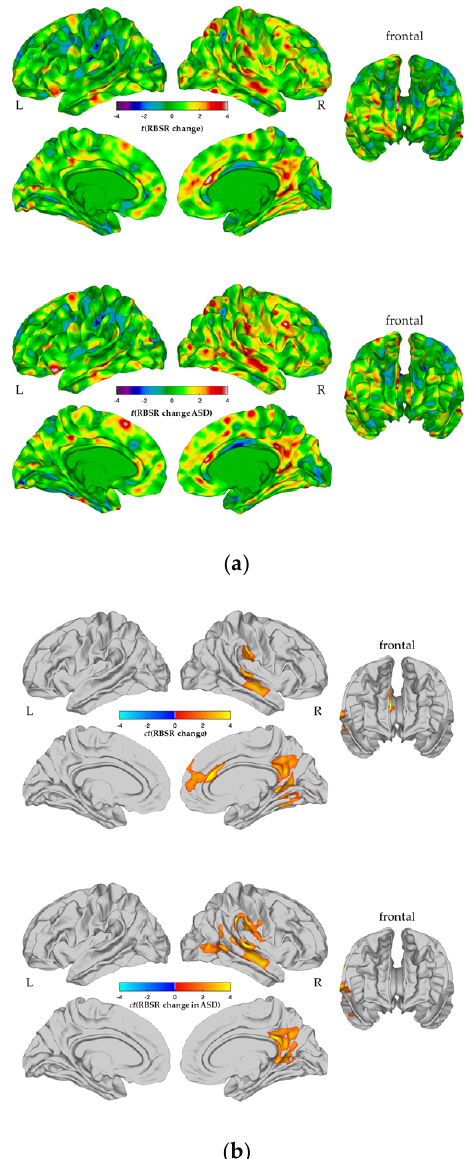
Figure 4. Main effect of a change in restricted and repetitive behaviors (RRBs) on vertex-wise differences in the change in Cortical Thickness (CT spc ). A significant main effect of developmental changes in the total severity in RRBs was quantified as the difference in the total severity on the RBS-R between timepoint 1 and timepoint 2 [ ∆ RBSR total severity (T2-T1)], on vertex-wise differences in the developmental change in CT (CT spc ) across the total sample [upper figures in ( a ) and ( b )], and only within individuals with ASD [bottom figures in ( a ) and ( b )]. The unthresholded t-maps are displayed in ( a ) and the random field theory (RFT)-based, cluster corrected ( p < 0.05, 2-tailed) difference maps, determined following multiple comparisons are in ( b ). Associations between increases in the RBS-R severity from T1 to T2 with vertex-wise changes in CT were marked in yellow to red (left panel), respectively, and in red to yellow (right panel), and associations between decreases in RBS-R severity from T1 to T2 with vertex-wise changes in CT were marked in cyan to purple (left panel), respectively, and in blue to cyan (right panel). Abbreviations: L: left hemisphere, R: right hemisphere. The green to red color scale indicates regions with an increased CT in the ASD group relative to the control group, while the blue to violet color scale indicates vertices with a decreased CT in the ASD group relative to the control